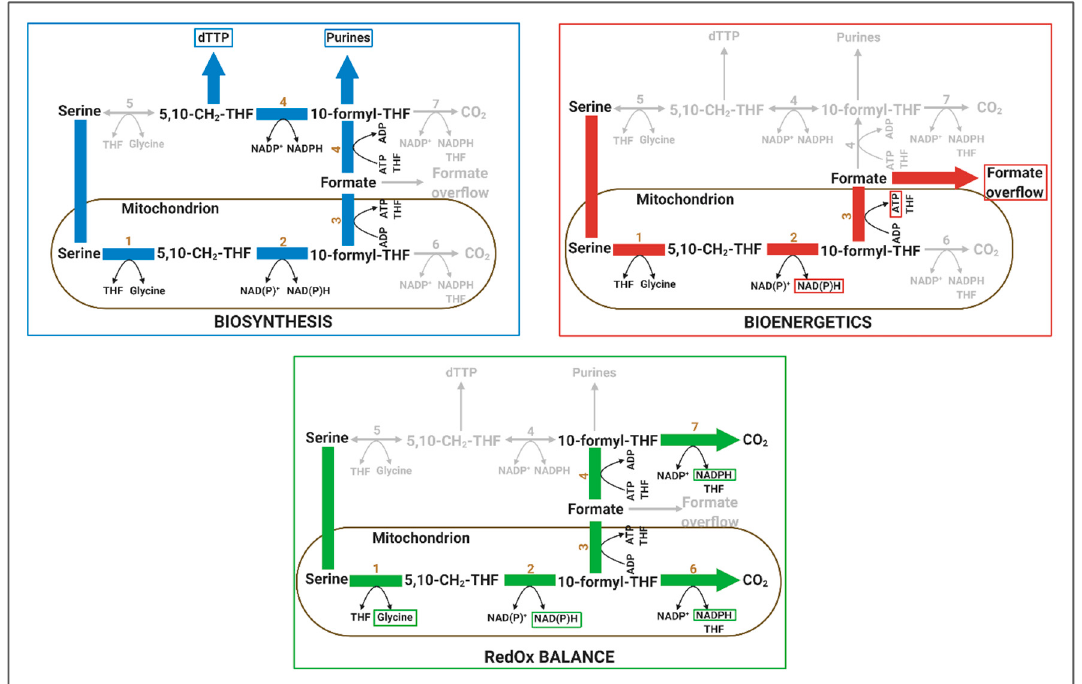
Figure 2. One-carbon cycle and its theoretical potential in supporting biosynthesis, bioenergetics and RedOx balance . One-carbon (1C) cycle can support biosynthesis through the generation of 10-formyl-THF and 5,10-CH 2 -THF. When formate is released from the 1C cycle, this yields one NADH and one ATP molecule per serine supporting energy balance. Alternatively, the 1C unit can be released as CO 2 generating NADPH in the process through the action of ALDH1L1/2. NADPH can also be generated from the action of MTHFD2/L. In addition, serine-derived glycine can be used for purine synthesis (biosynthesis) or GSH synthesis (RedOx). Enzymes are abbreviated